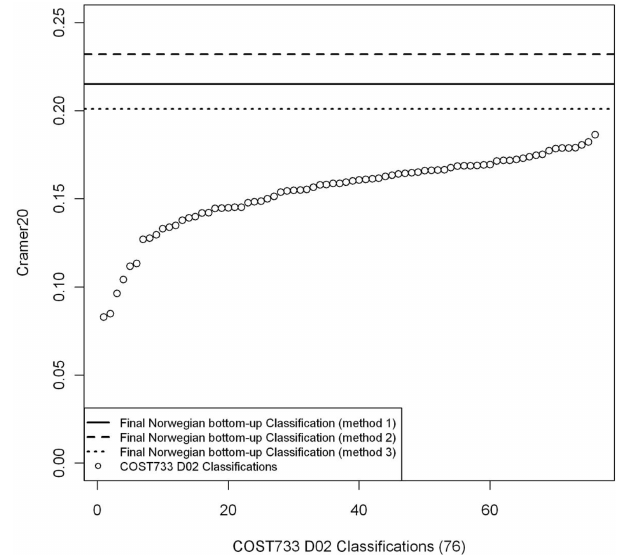
Figure 3. Distribution of Cramer20 scores for the 76 COST733 classifications, as compared with the scores for the three classifi- cations described in Sect.